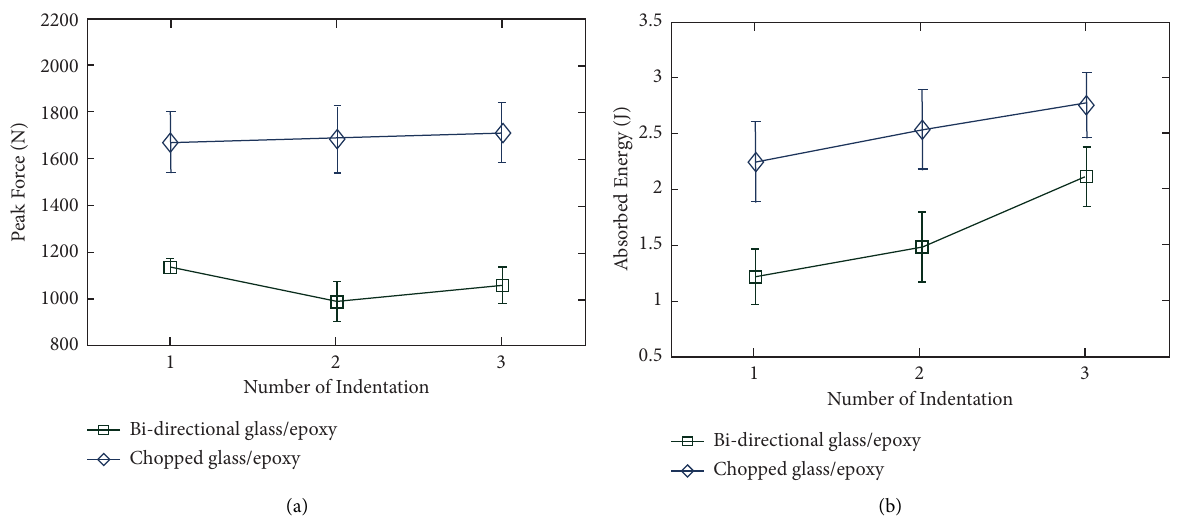
Figure 6: (a) Number of indentations vs. peak force and (b) number of indentations vs. absorbed energy for the phases of glass fiber reinforcement.